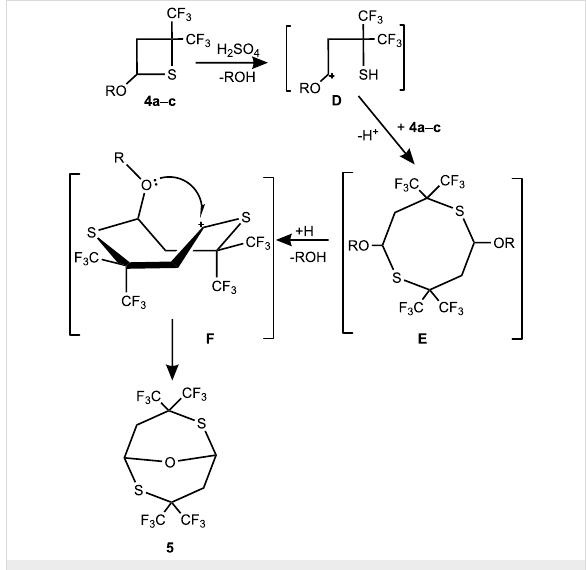
Scheme 8: Putative mechanism for the formation bicyclic ether 5